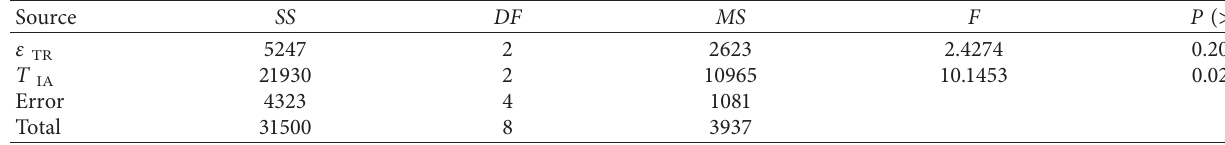
Table 5: ANOVA for yield strength.